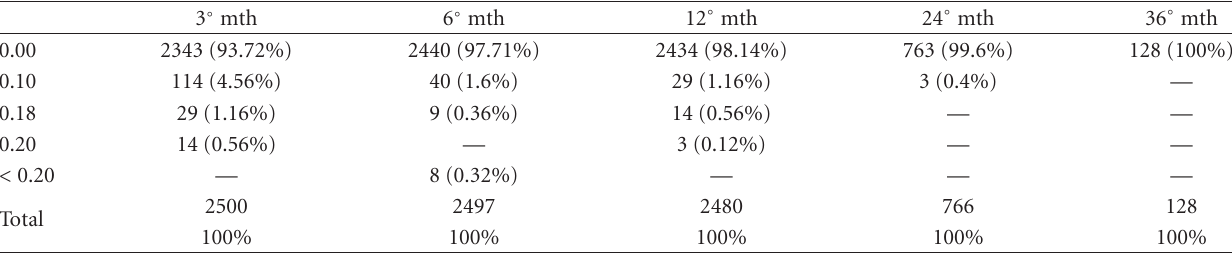
Table 5: UNVA in each postoperative period.